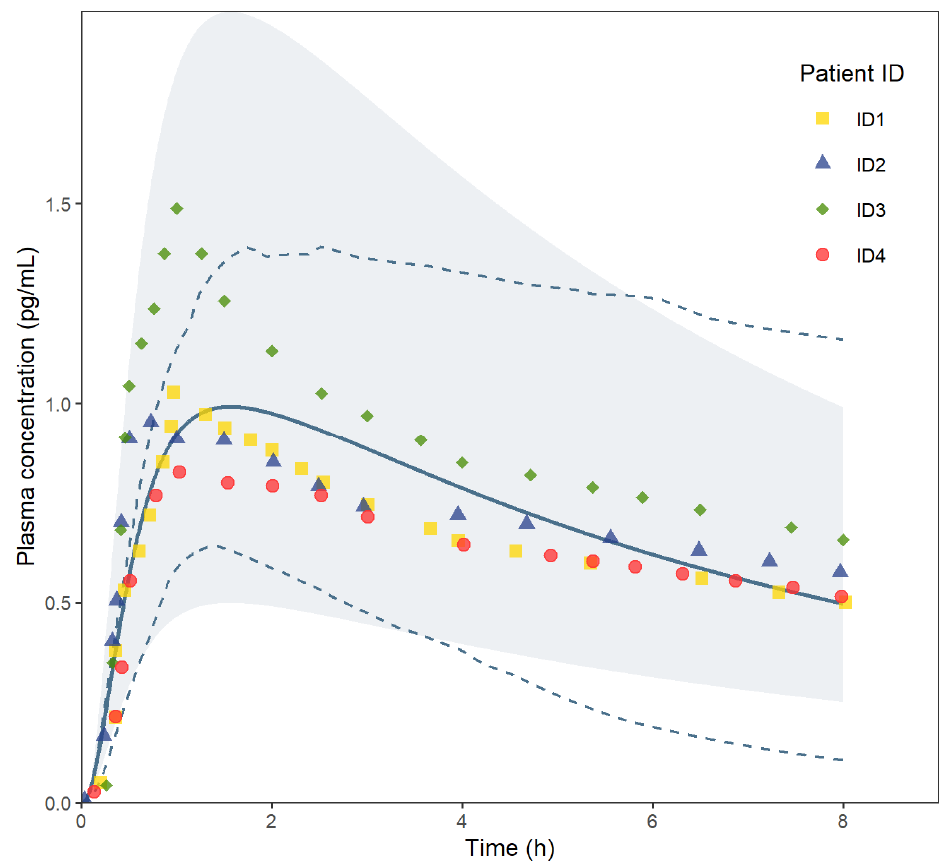
Figure 3. AFB1 plasma concentration (pg/mL) versus time (h) curve: predicted data by the PBPK model are shown by the blue line, and the observed data points of the four subjects from the in vivo trial are represented as coloured symbols (each colour represents a subject). The light blue area shows the twofold prediction. The dashed blue lines give the 5th–95th percentiles of the predicted plasma concentrations.